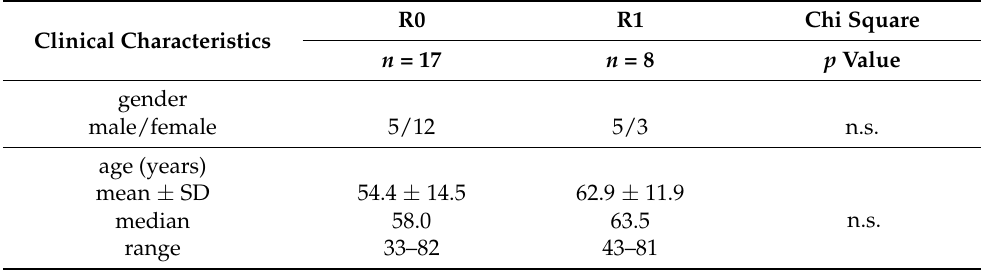
Table 1. Baseline characteristics of patients undergoing R0 and R1 resection. Clinical